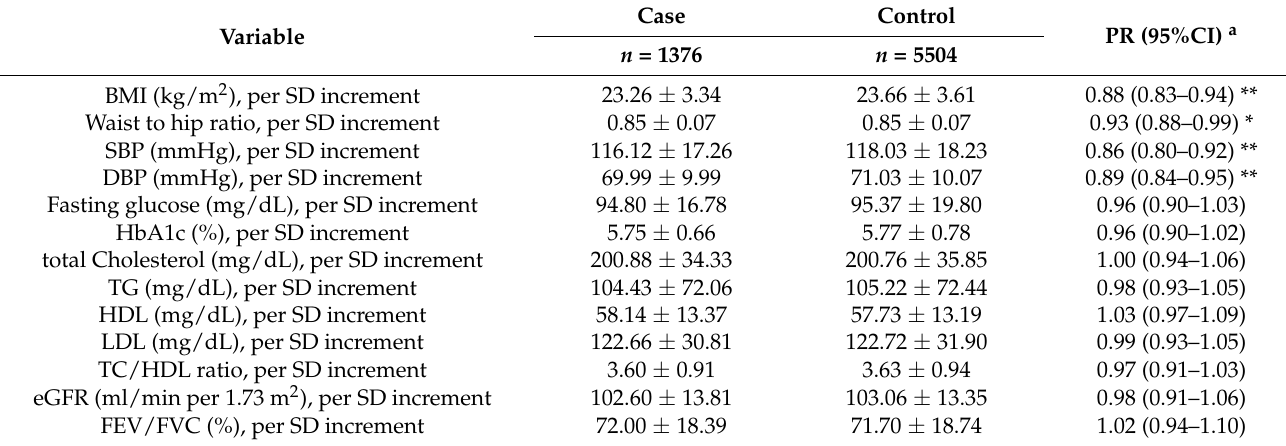
Table 2. Associations between clinical biochemistry index and individual histories of diseases as well as dry eye syndrome.